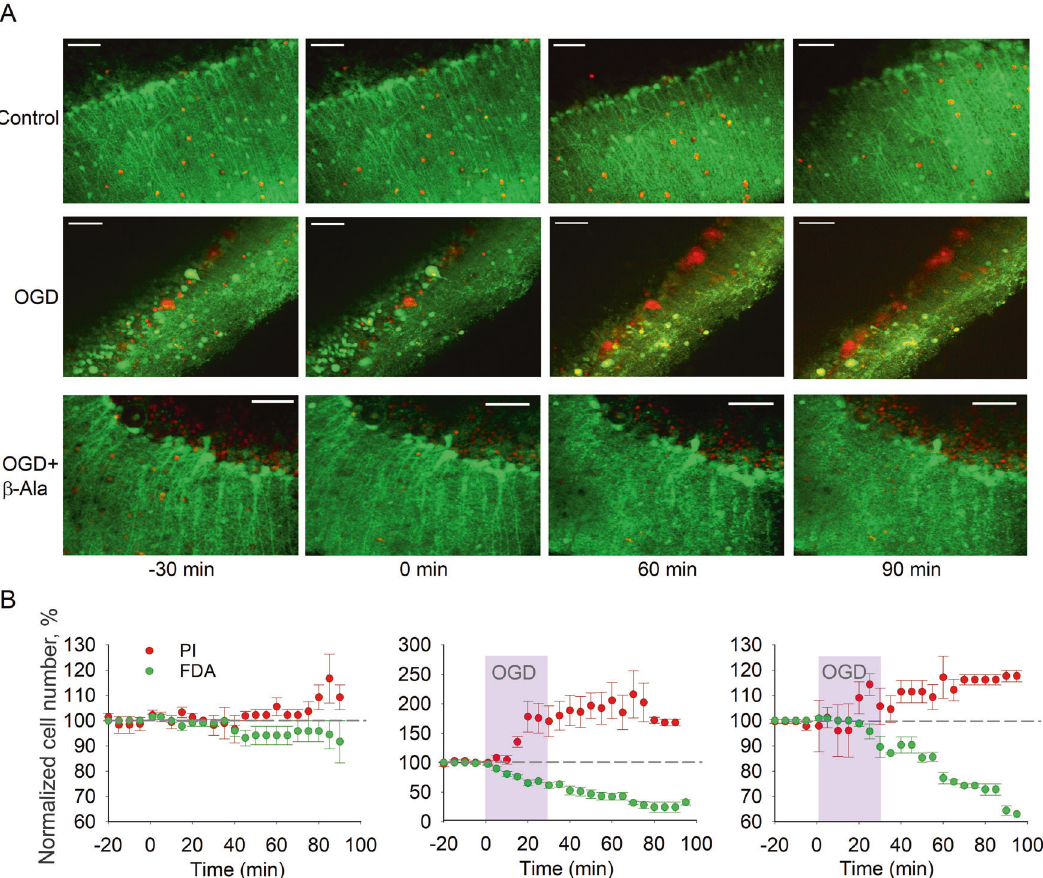
Fig. 2 β -Ala prevents the OGD-induced death of PCs. A Experimental arrangement same as shown in Fig. 1A, but for the PC layer. Examples of time-lapse 2PE images of PCs in acute cerebellar tissue slice over the time of recording in different experimental conditions. Images, Z-projection of the PC layer (merged FDA and PI fl uorescence channels). From top to bottom: a control acute cerebellar tissue, a slice subjected to OGD and OGD in the presence of β -Ala, as denoted. Time marks at the bottom apply to all images; “ 0 m ” time mark denotes the start point of OGD (30-m duration). B Summary of image analyses for the number of viable (FDA fl uorescence) vs. dead PCs (PI, red fl uorescence) over the time in control ( n = 7 slices/5 animals, left plots), OGD (30-m duration) followed by reperfusion ( n = 8 slices/5 animals, middle) and OGD in the presence of β -Ala ( n = 5 slices/3 animals, right plots). Data normalized to the control values (image captured 30 m before the OGD onset corresponds to 100% level). Notes apply to all three